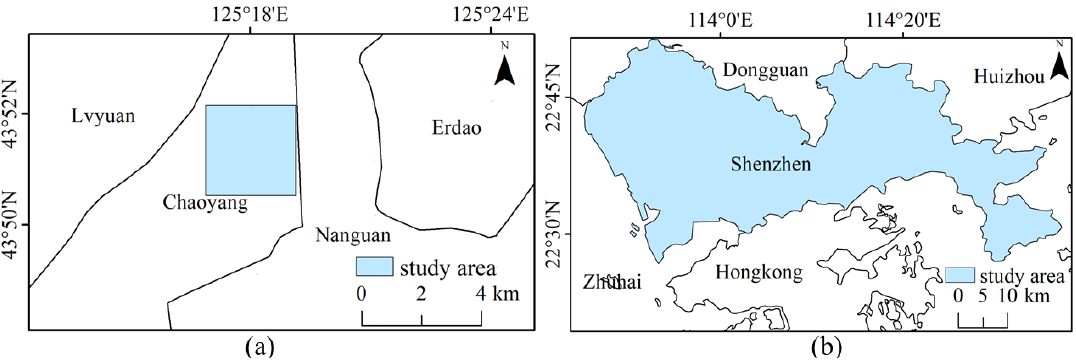
Figure 3. Experimental areas: ( a ) Chaoyang District, Changchun City; ( b ) Shenzhen City.